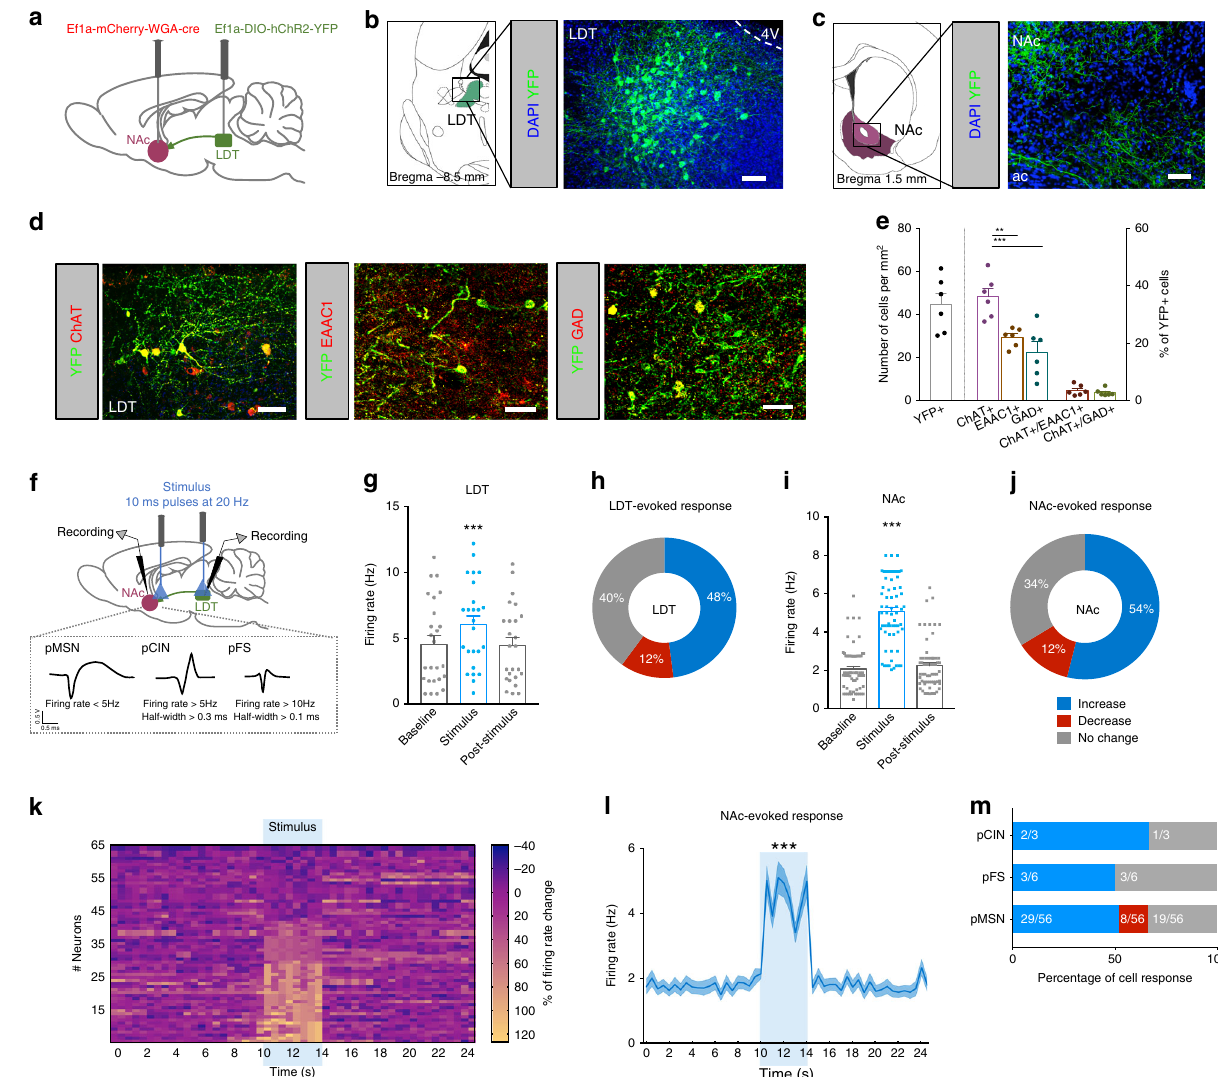
Fig. 1 LDT stimulation drives a predominantly excitatory response in the NAc. a Strategy used for LDT-NAc optogenetic manipulation. b Representative immuno fl uorescence showing YFP staining in the LDT and c in terminals in the NAc; scale bar = 100 μ m. d Representative immuno fl uorescence for eYFP (green) and ChAT, EAAC1 or GAD65/67 (red); scale bar = 50 μ m. e Respective quanti fi cation of double and triple positive cells, indicative of transfected neurons ( n = 6 animals, 1way ANOVA). f Electrophysiological strategy for cell recording in the LDT and in the NAc. NAc neurons were separated into pMSNs, pCINs, and pFS. g LDT neurons increase fi ring rate in response to optical activation of LDT cell bodies (80 pulses of 10ms at 20 Hz) (n = 5 animals; 25 LDT cells; 1way ANOVA). h 48% of LDT recorded cells increase their fi ring rate during stimulation. i NAc cells increase fi ring rate in response to LDT optical stimulation ( n = 9 animals; 65 cells; 1way ANOVA). j Around half of recorded cells in the NAc show an increase in the fi ring rate upon stimulation, 34% present no change and 12% decrease activity. k Heatmap representation of percentage of cell responses in the NAc when LDT terminals are stimulated. Each row represents a neuron. l Average distribution of the fi ring rate of NAc neurons showing an increase in activity during stimulation period (KS test). m 52% of recorded pMSNs increase their activity (29/56 cells), 34% did not change fi ring rate (19/56 cells) and 14% decrease their activity (8/56 cells); 67% pCINs (2/3 cells) and 50% pFS (3/6 cells) interneurons increase and 33% pCINs (1/3 cells) and 50% pFS (3/6